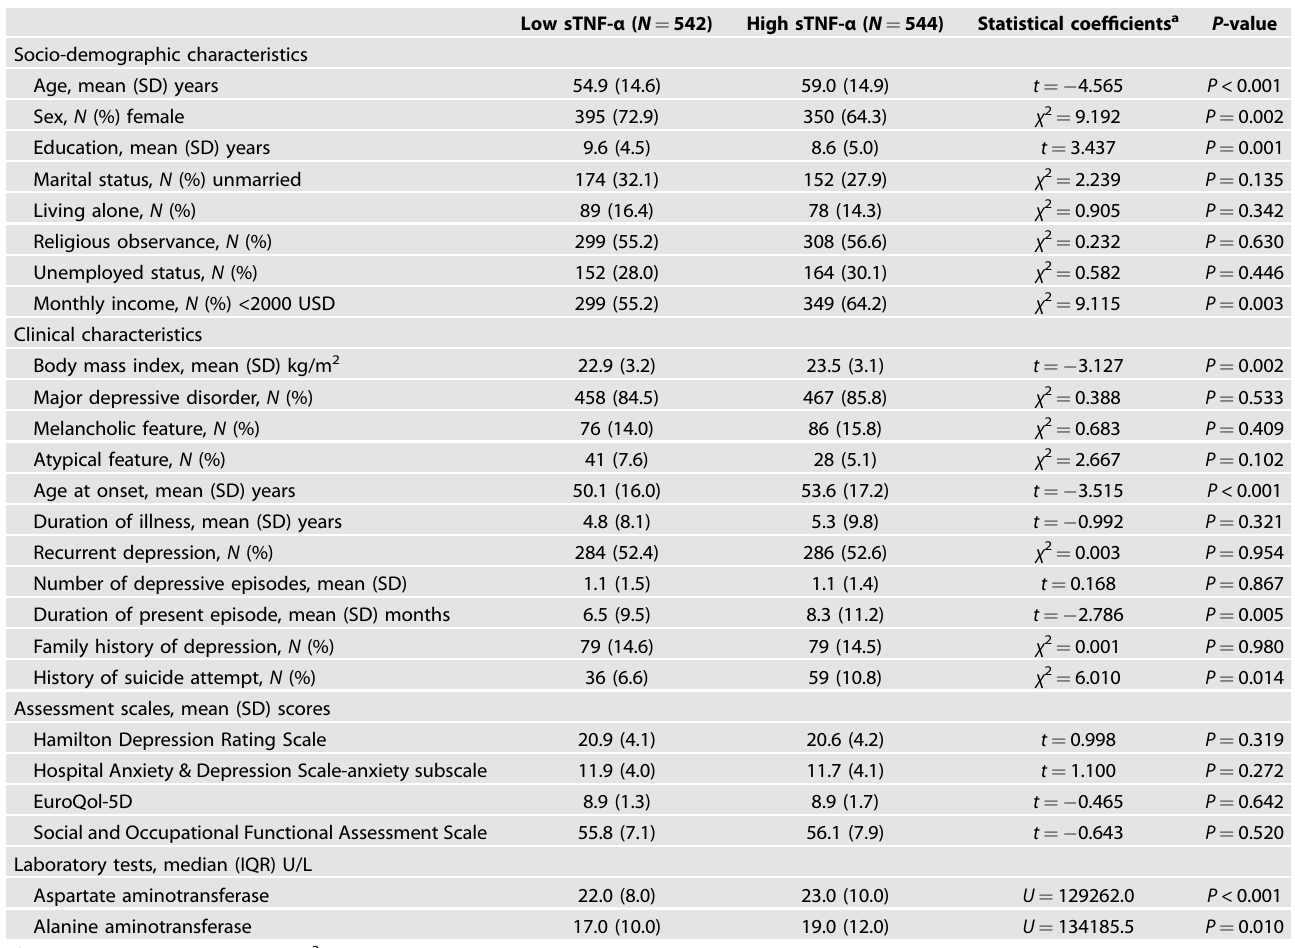
Table 1. Baseline characteristics according to serum tumor necrosis factor- α (sTNF- α ) level in patients with depressive disorders, who underwent 12 weeks of treatment ( N =